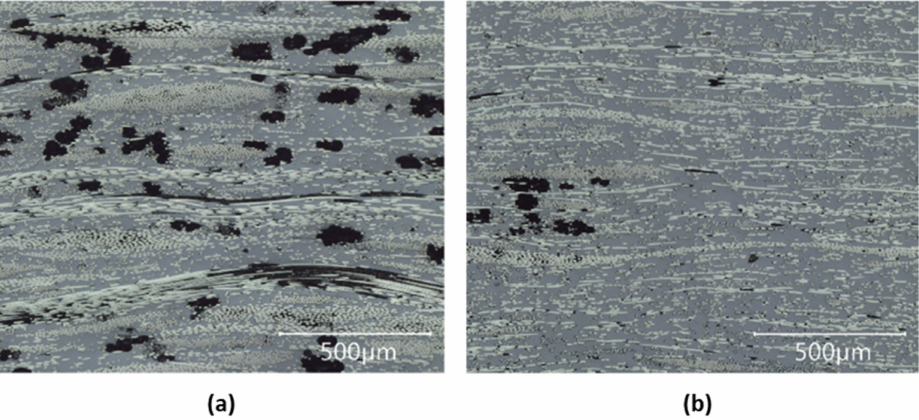
Figure 5. Optical micrographs of composite cross-sections for ( a ) repurposed fiber wet-laid composites and ( b ) recycled fiber carded composites. Reprinted with permission from [24]. Copyright 2021